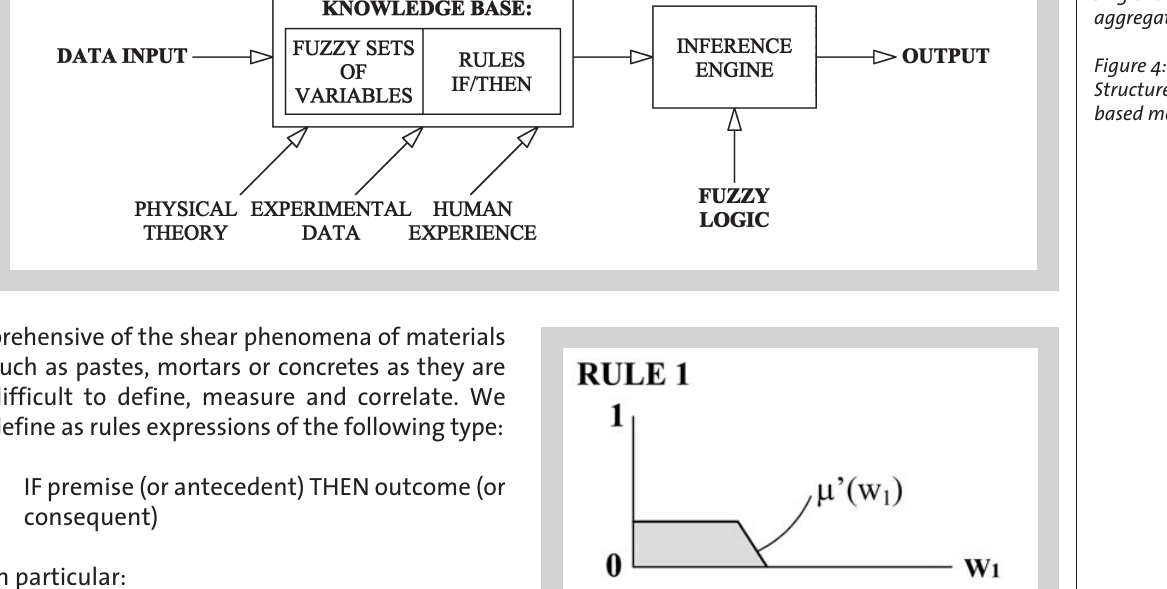
Figure 3 (left): Graphical illustration of single rules output aggregation. Figure 4: Structure of fuzzy rules- based model